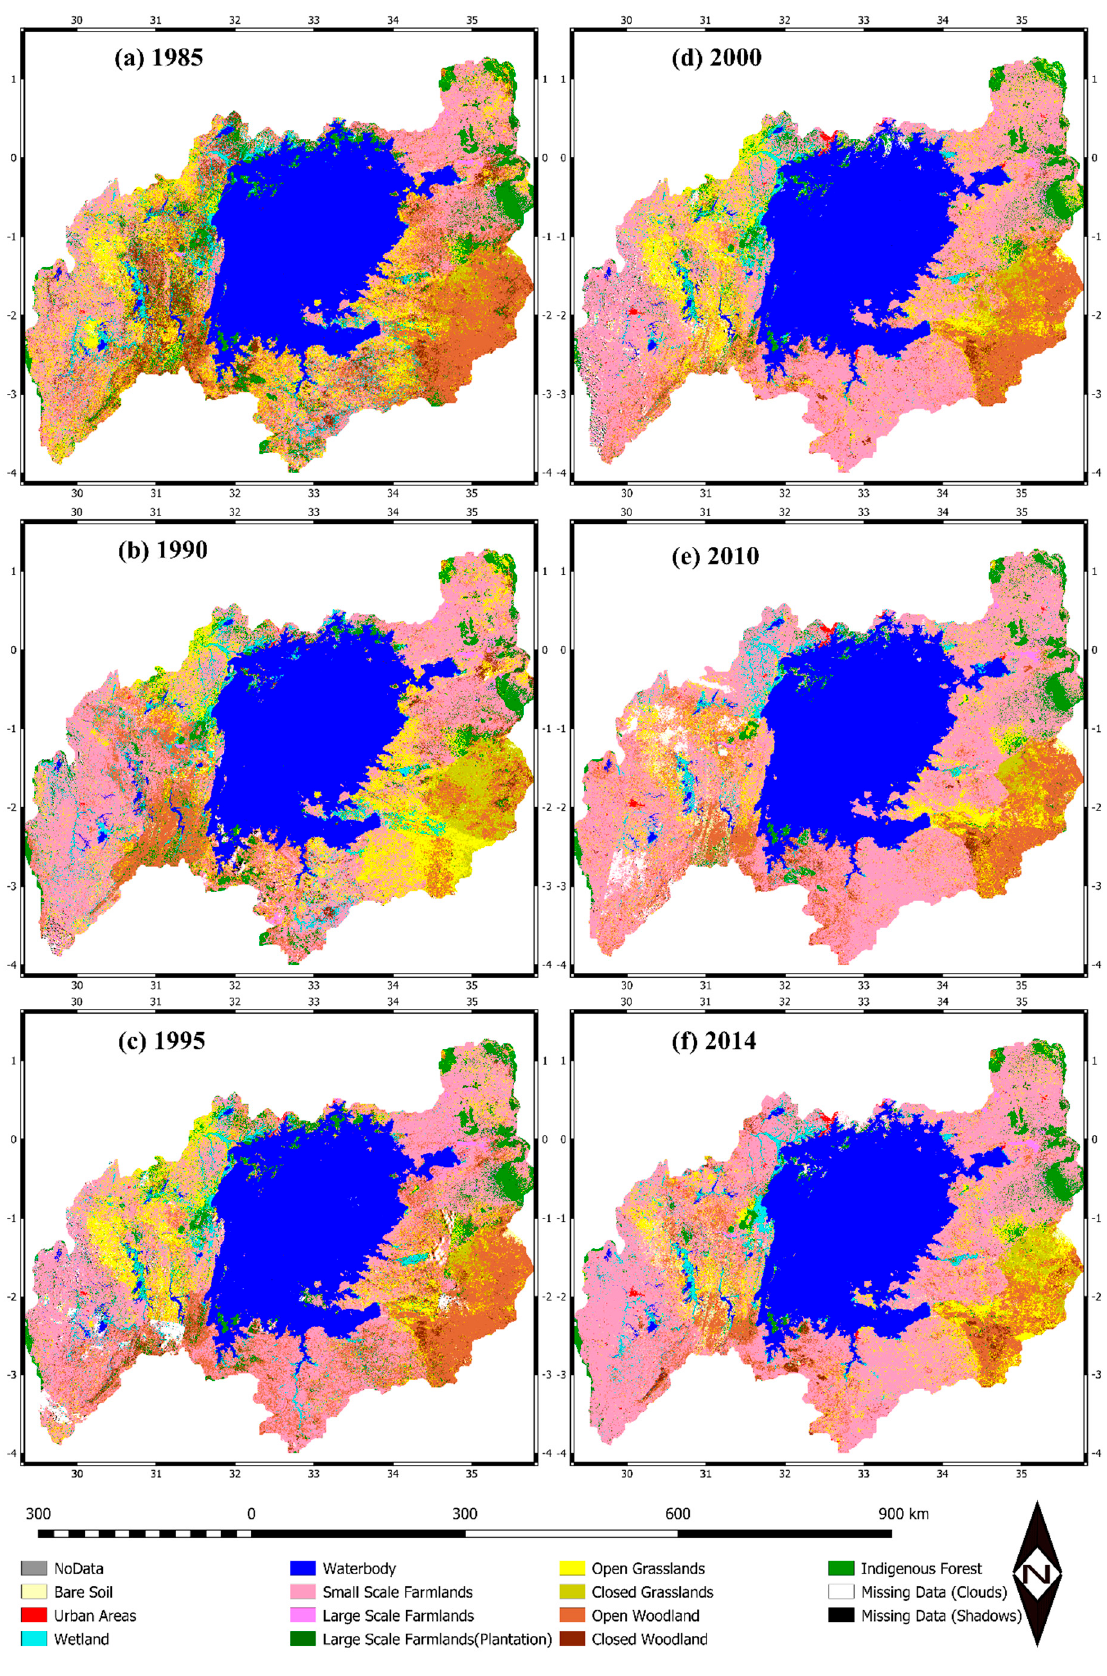
Figure 3. Land cover maps of the LVB for ( a ) 1985, ( b ) 1990, ( c ) 1995, ( d ) 2000, ( e ) 2010, and ( f ) 2014.